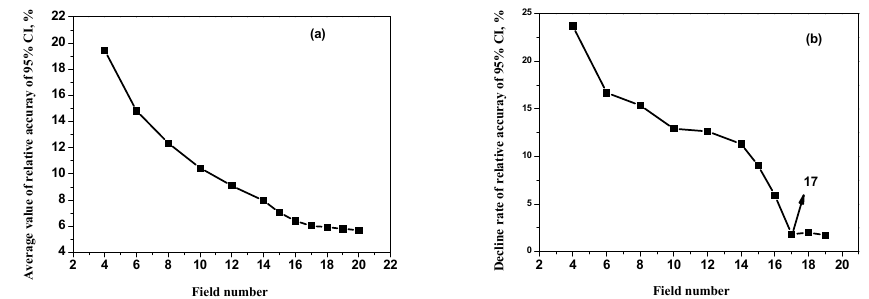
Figure 10. The variation curves of the average relative accuracy of 95% confidence interval ( a ) and its decline rate ( b ) with different fields for TRIP590 steel.